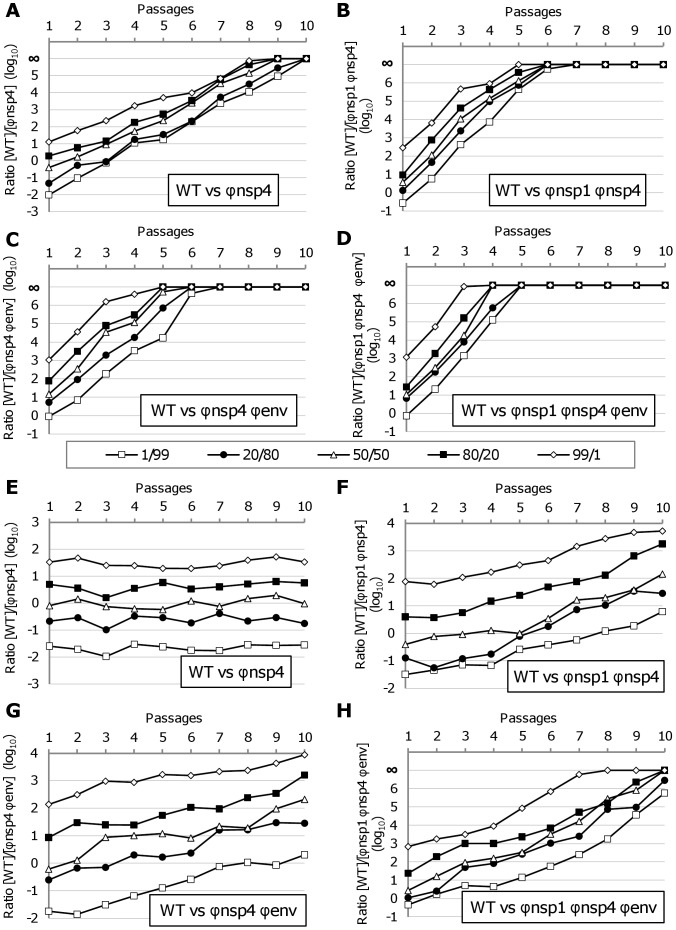
Competition experiments.Using two real time RT-PCR assays, specific for the WT virus or the viruses with the nsP4 region re-encoded (Φnsp4, Φnsp1 Φnsp4, Φnsp4 Φenv and Φnsp1 Φnsp4 Φenv viruses), competition experiments were performed in Vero (A–D) and C6/36 (E–H) cells. Five initial PFU ratios (WT/re-encoded virus: 1/99, 20/80, 50/50, 80/20, 99/1) were used. This enabled us to quantify the proportion of each virus in the viral population (expressed as log10 WT/re-encoded ratio). In addition, cell supernatants were passaged 10 times to enable long term follow-up of each viral population.